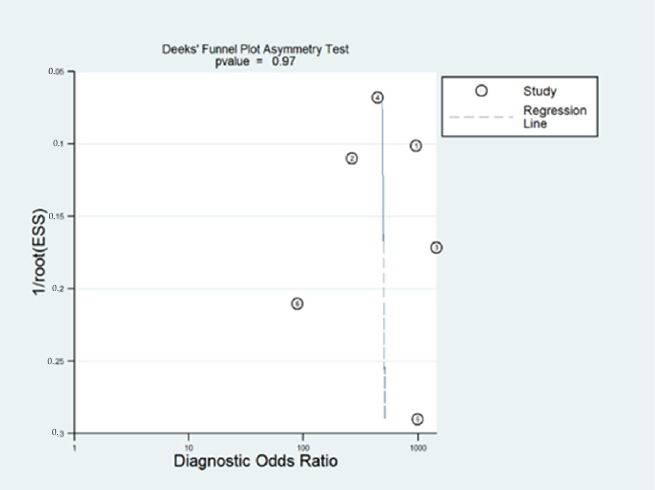
Figure 6. Deeks’ Funnel Plot Asymmetry Test showing the publication bias of the included articles.